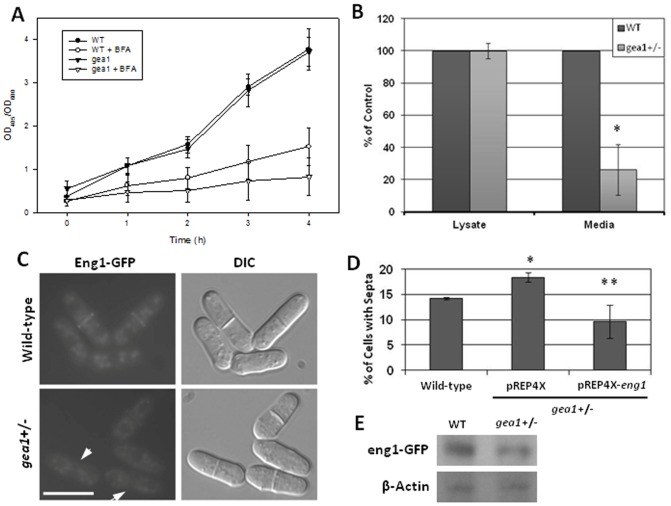
Secretion of the β-glucanase eng1p is selectively inhibited in gea1+/− cells.A. Equal numbers of wild-type and gea1+/− S. pombe cells were used to inoculate 10 mL of EMM media. At the indicated times, an aliquot of the media was subjected to spectrophotometric determination of secreted acid phosphatase activity by monitoring cleavage of the substrate p-nitrophenyl phosphate at 405 nm. Acid phosphatase activity was normalized to cell density, determined by monitoring absorbance at 600 nm (OD600). Treatment with 40 µg/mL BFA to inhibit secretion served as a negative control. B. β-glucanase activity in cell lysates and in media was measured by quantifying release of reducing sugars from the substrate laminarin as previously described [68]. Normal levels of β-glucanase activity were detected in wild-type and gea1+/− cell lysates, but β-glucanase activity was decreased in the media from gea1+/− cells. Error bars represent the mean ± SD from 3 independent experiments. *p<0.02 C. Wild-type and gea1+/− cells expressing eng1p tagged with GFP under control of the endogenous promoter were imaged by fluorescence microscopy. Localization of eng1-GFP to the septum was substantially decreased in gea1+/− cells. Arrows indicate septated cells with no visible eng1-GFP at the septum. Scale bar, 10 µM. D. Gea1+/− cells were transformed with either the empty pREP4X vector or pREP4X carrying eng1. Wild-type and both gea1+/− strains were then stained with calcofluor, and the percentage of cells with septa were counted for each culture. Overexpression of eng1p rescued the excessive septation defect of gea1+/− cells. Error bars represent the mean ± SD from 3 independent experiments. *p<0.02 compared to wild-type. ***p<0.05 compared to gea+/− + pREP4X. E. Lysates from wild-type and gea1+/− cells in which endogenous eng1 was tagged with GFP (shown in C) were subjected to immunoblot analysis using antibodies directed against GFP and β-actin. No significant difference in eng1p-GFP levels was observed between the wild-type and gea1+/− cells (p = 0.70).